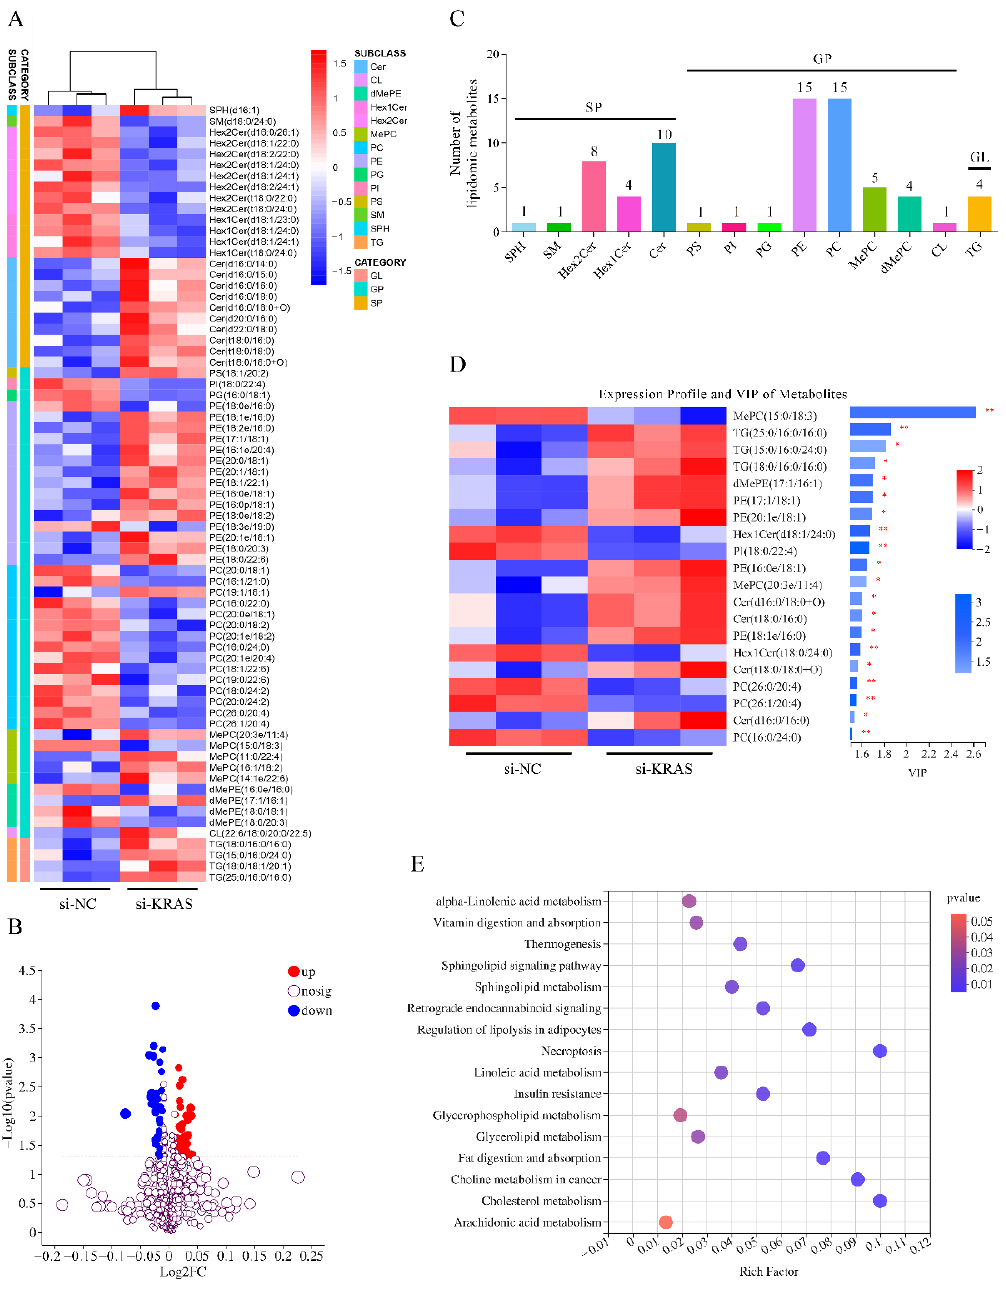
Figure 2. Effects of Kirsten rat sarcoma viral oncogene homolog (KRAS) on lipid composition in MAC-T cells. ( A ) Heatmap of all the differential lipidomic metabolites after KRAS inhibition. In the figure, each column represents a sample, each row represents a metabolite, and the color indicates the relative level of metabolites expressed in the group. Red indicates that the metabolite is expressed at high levels, and blue indicates lower expression. ( B ) Volcano plot of the differentially lipidomic metabolites. Each dot in the figure represents a metabolite, and the size of the dot indicates the variable importance in the projection (VIP) value. The blue dots are significantly downregulated metabolites, and the red dots are significantly upregulated metabolites. ( C ) Identified differential lipidomic metabolites were classified. ( D ) Differential metabolites with VIP > 1.5 from the VIP plot based on the OPLS-DA models. ( E ) KEGG pathway enrichment of differential lipidomic metabolites. The size of bubbles in the figure represents the amount of differential metabolites, and the color of bubbles represents the p -values. Significant differences are represented with * ( p < 0.05) and ** ( p < 0.01).